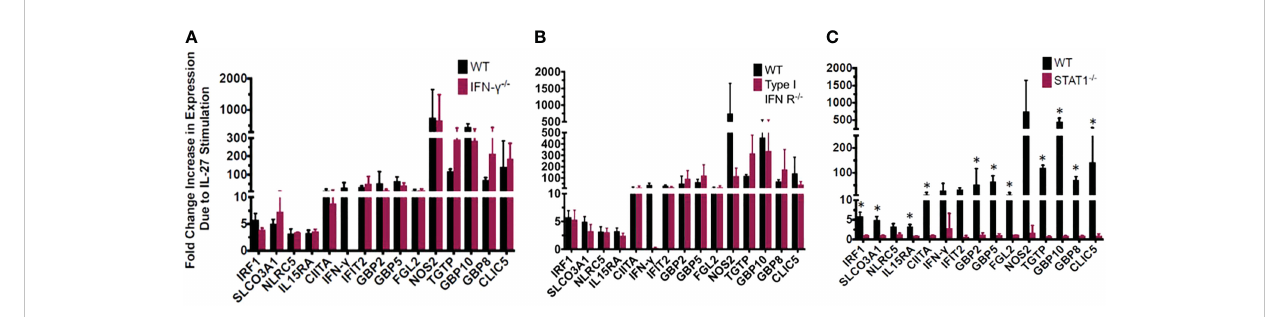
FIGURE 3 Most of the IL-27-induced “ IFN signature ” is not secondary to IFNs but is dependent on Stat1. The exception is induction of IFN g which required both type I IFN and Stat1. IL-27-induced gene expression detected by real time RT-qPCR in wild type macrophages relative to those with genetic